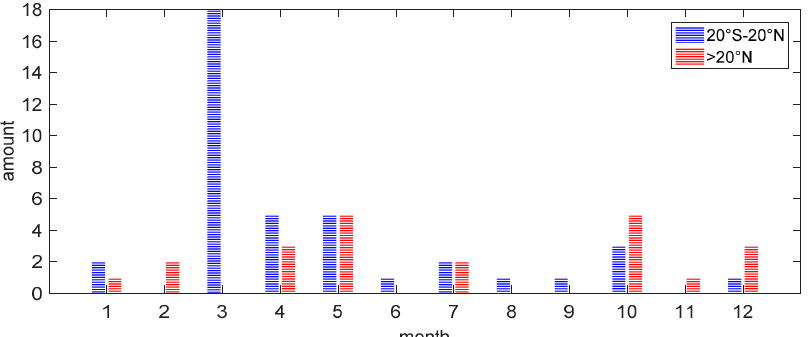
Figure 9. Mesospheric bore months at different latitudes. Blue denotes the tropical region (20°S–20°N); red denotes the region north of 20°N.